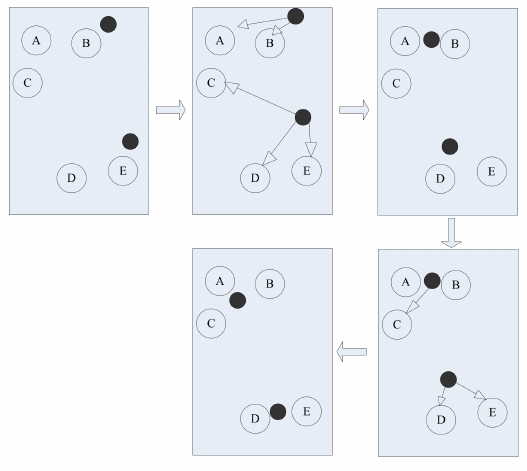
Figure 2. K-means clustering principle